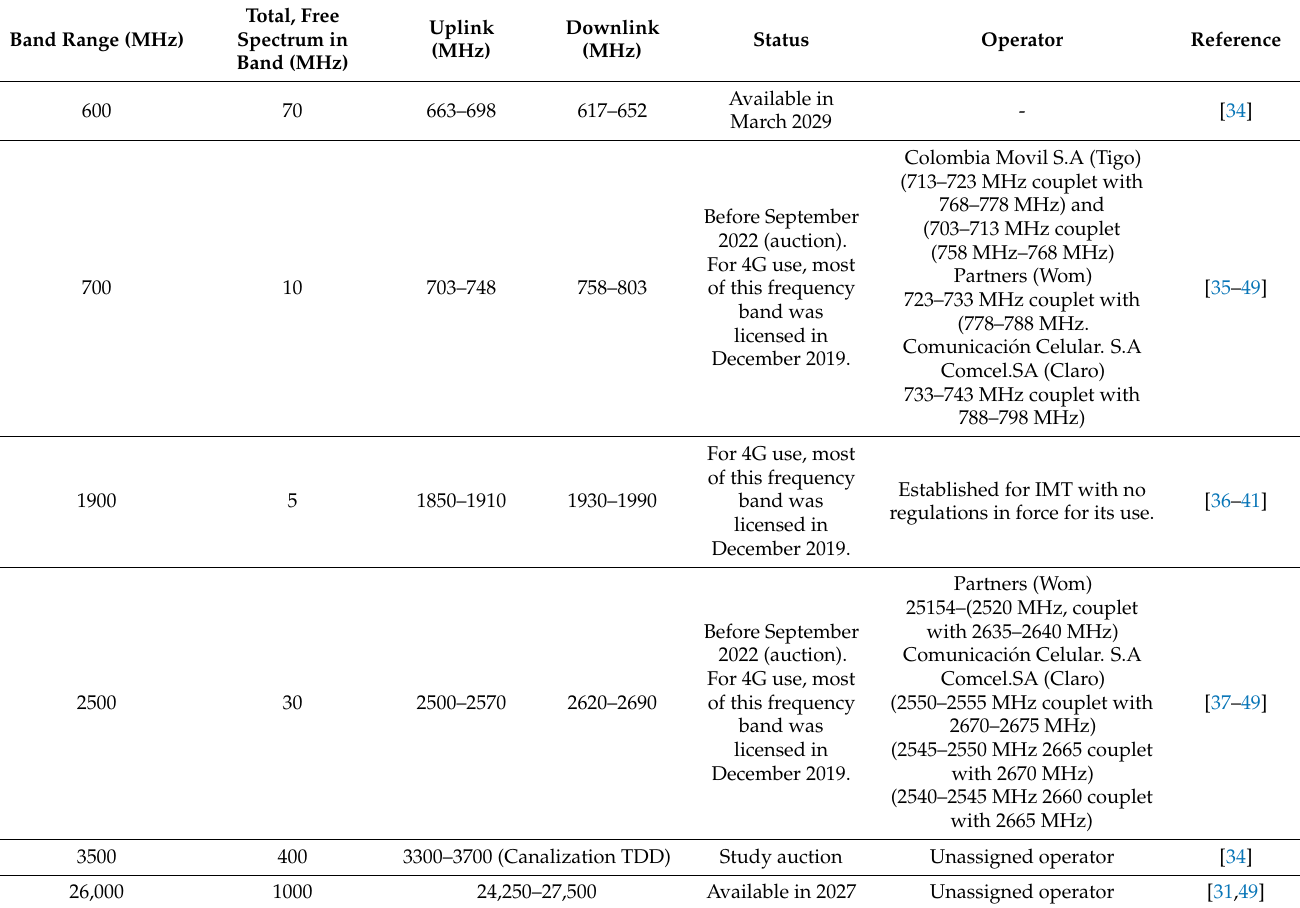
Table 2. Status of 5G band projections in Colombia.